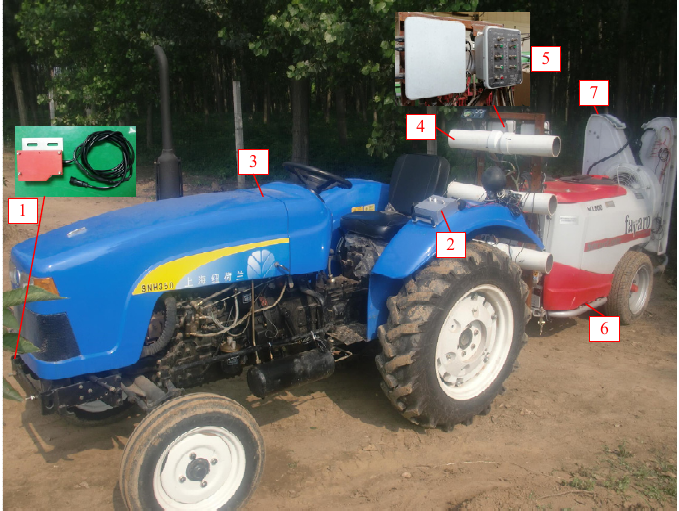
Figure 1. Orchard target-oriented sprayer: 1. photoelectric sensor; 2. photoelectric-based target-oriented controller; 3. tractor; 4. ultrasonic sensor; 5. ultrasonic-based target-oriented controller; 6. tank; and 7. spray unit.